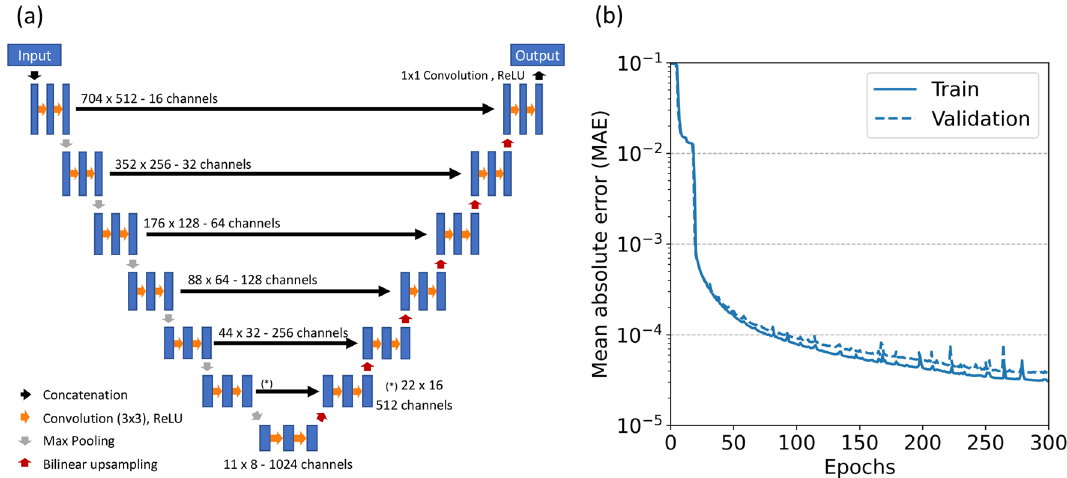
Figure 1. a The virtual monoenergetic micro cone-beam CT (vMonoCT) network architecture. b The mean absolute error (MAE) loss function of the vMonoCT network plotted against the number of epochs for the training and validation